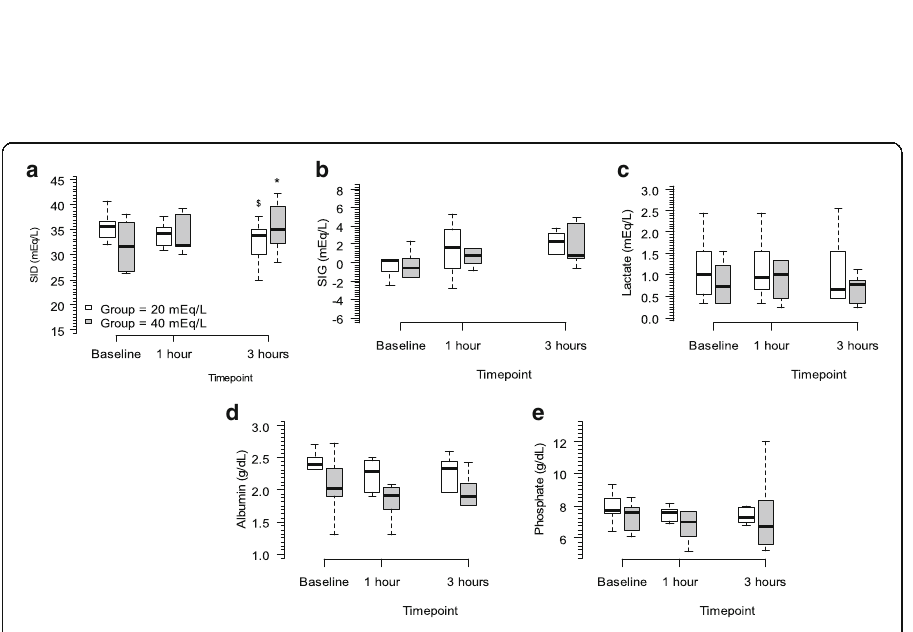
Fig. 2 Temporal metabolic determinants of SBE variation based on group. Panel a shows the SID changes over time (mixed model: group vs. SIDa interaction, P = 0.021; timepoint vs. SIDa interaction, P < 0.001; timepoint vs. group interaction, P < 0.001). Panel b shows the SIG changes over time (mixed model: group vs. SIG interaction, P =0.483; timepoint vs. SIG interaction, P =0.797; timepoint vs. group interaction; P =0.364). Panel c shows the lactate changes over the time (mixed model: group vs. lactate interaction, P =0.473; timepoint vs. lactate interaction, P =0.936; timepoint vs. group interaction, P =0.871). Panel d shows the albumin changes over time (mixed model: group vs. albumin interaction, P =0.182; timepoint vs. albumin interaction, P =0.833; timepoint vs. group interaction, P =0.432). Panel e shows the phosphate changes over time (mixed model: group vs. phosphate interaction, P =0.565; timepoint vs. phosphate interaction, P =0.450; timepoint vs. group interaction, P =0.531). SID denotes strong ion difference. SIG denotes strong ion gap. SBE denotes standard base excess. *Wilcoxon post hoc analysis, P <0.05 vs. baseline. $Mann-Whitney post hoc analysis, P <0.05 vs. group